Question: Looking at the figure, what chart type is it?
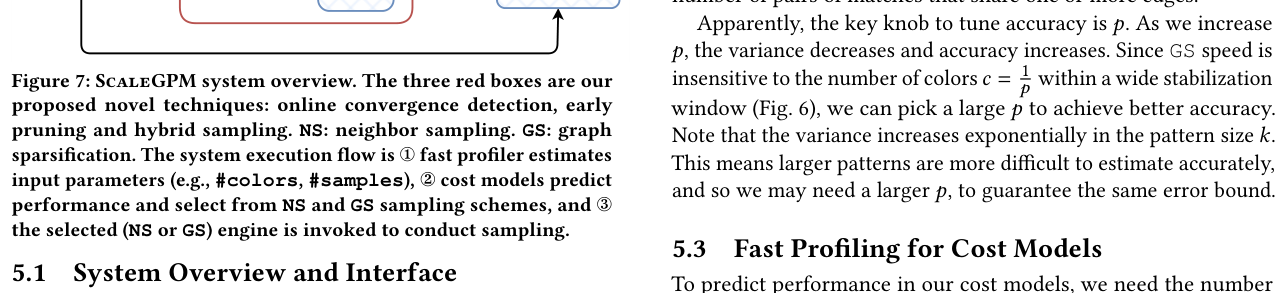
Answer: line